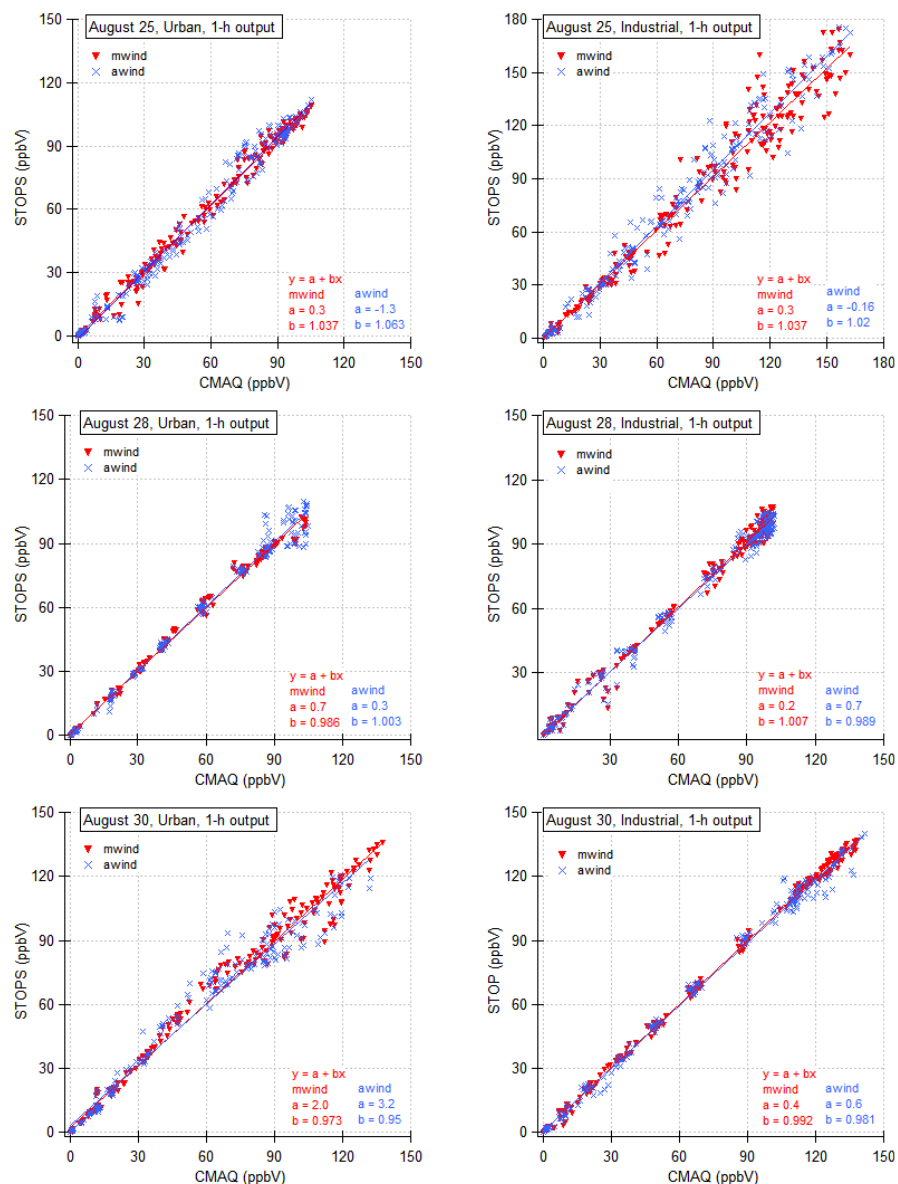
Figure 5. Comparison of ozone concentrations obtained with STOPS and CMAQ for 25, 28, and 30 August for the STOPS starting position in the urban sub-domain (left figures) and the industrial sub-domain (right figures). Red triangles correspond to the trajectory determined from winds in the middle column (mwind), blue crosses to the trajectory from average winds in the whole STOPS domain (awind). Compared are values from each cell in the first model layer, at every output time step. Note: the scale is adjusted to the maximum ozone concentration on a given day.